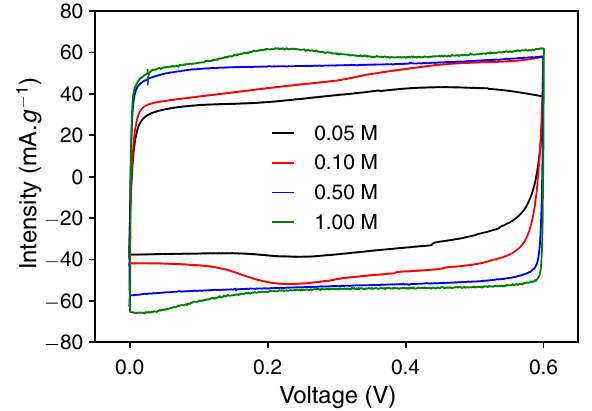
FIG. 2. Cyclic voltammograms of electrochemical cells based on CDC and aqueous solutions of sodium chloride at concen- trations ranging from 0.05 to 1.0 M as electrolytes. The potential scan rate is 1 mV s − 1 .